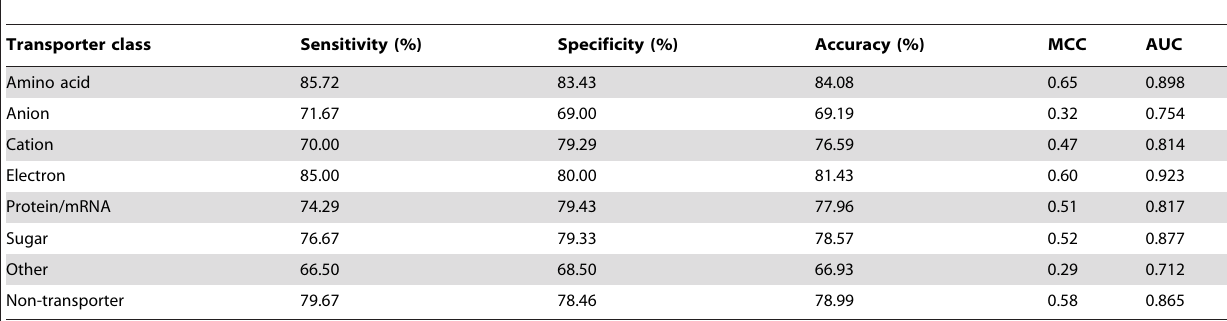
Table 2. The performances of the best models on the main dataset for different substrate-specific transporter classes.